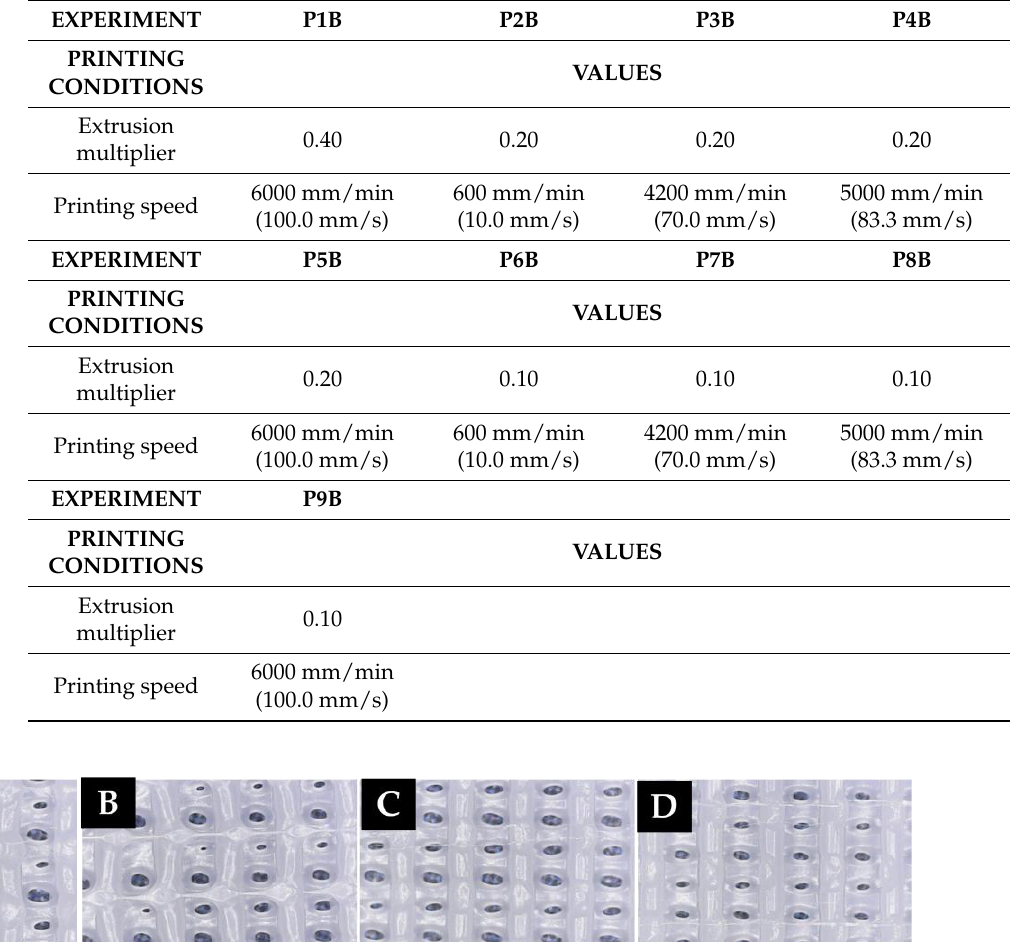
Table 6. Printing parameters of experiments P1B-P9B.